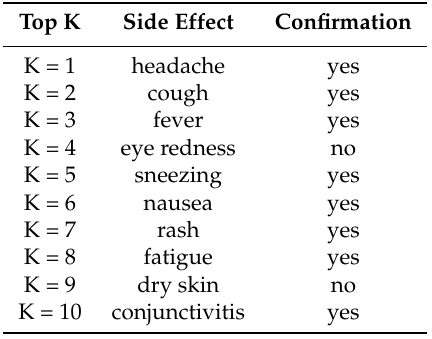
Table 7. Prediction of the top 10 side effects for triamcinolone based on SDHINE. Top K Side